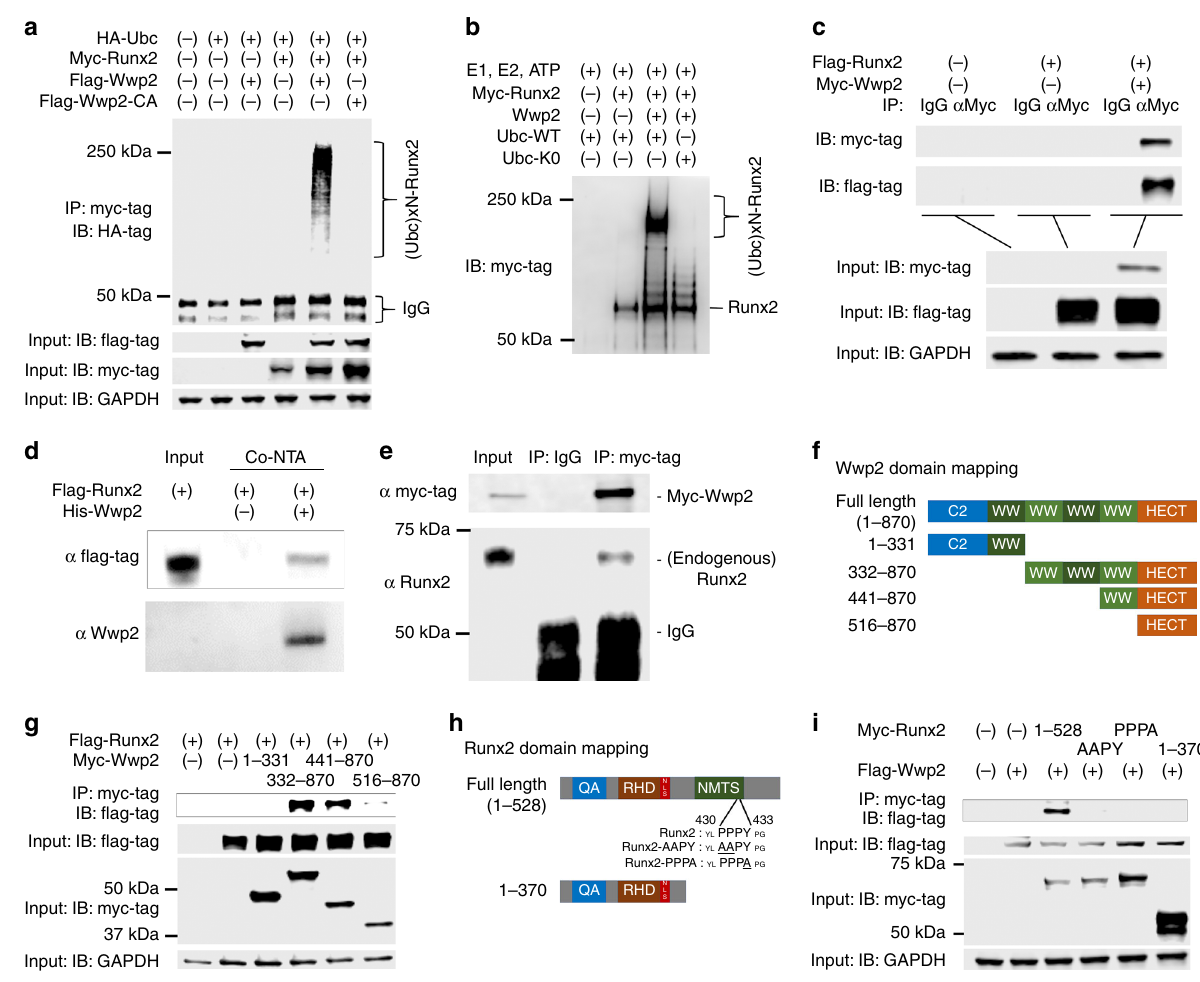
Fig. 6 Wwp2 induces poly-ubiquitination of Runx2. a An immunoprecipitation (IP) experiment to detect ubiquitinated Runx2. HEK293T cells were transfected with plasmids (HA-ubiquitin (Ubc), myc (or fl ag)-Runx2, fl ag (or myc)-Wwp2, fl ag-Wwp2-CA) and treated with MG132 (10 μ M, 7 h). The cell lysates were treated by anti-myc-tag antibody and protein A. b In vitro ubiquitination assay to demonstrate Wwp2-induced poly-ubiquitination. Wwp2 and Runx2 proteins were puri fi ed from transfected HEK293T cells. c A Co-IP experiment to detect binding activity between Runx2 and Wwp2. HEK293T cells were transfected with plasmids and treated with MG132. The cell lysates were treated by anti-myc-tag antibody and protein A. d In vitro pull-down assay using His-tag. Proteins were puri fi ed from transfected HEK293T cells. e Myc-Wwp2 transduced ATDC5 chondrogenic cell line was used. Co-IP using anti- myc-tag antibody indicated Wwp2 bound with endogenous Runx2. f Schema of Wwp2 fragments for domain mapping. g Co-IP to con fi rm the binding domain of Wwp2 for Runx2. h Schema of Runx2 fragments and mutations for domain mapping. For the PY motif, mutations were introduced in PPPY sequence, such as AAPY or PPPA. i Co-IP to detect the binding sequence of Runx2 for Wwp2. These experiments were performed two or more times. Representative images are shown. Source data are provided as a Source Data fi le. C2, C2 domain; WW, WW domain; HECT, homologous to the